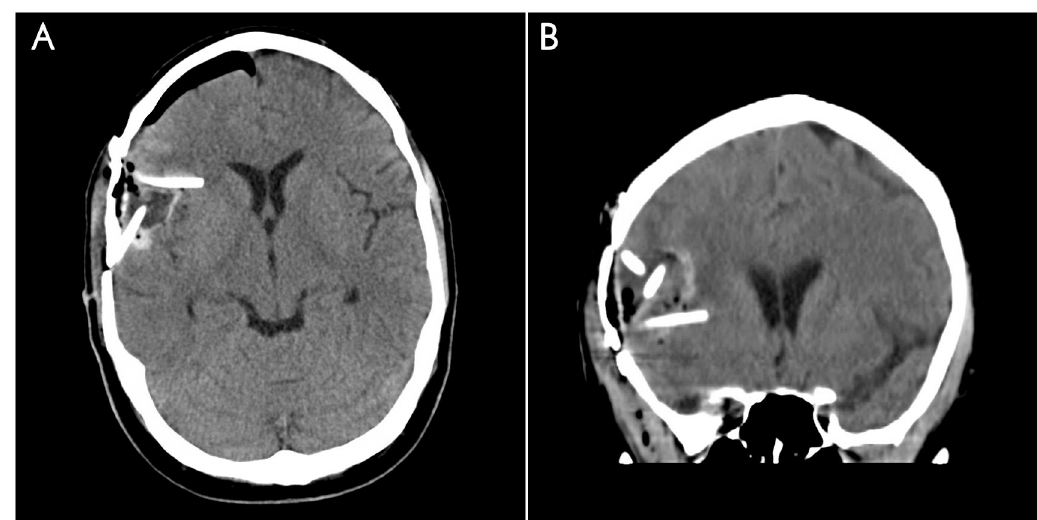
Fig 2. Postoperative imaging. Representative (A) axial and (B) coronal planes of a CT head on postoperative day 0 demonstrating postsurgical changes and three catheters traversing the lesion and entering the surrounding